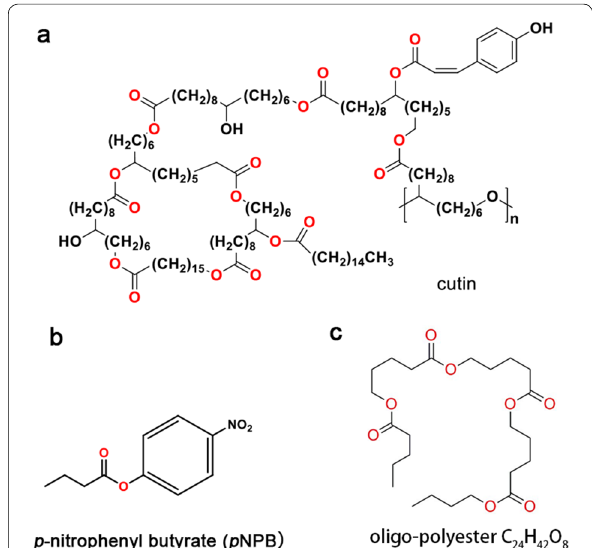
Fig. 1 Structures of compounds used in this study. a Cutin is the natural polyester substrate of cutinase. b p NPB is a small-model substrate of cutinase. The intramolecular ester oxygen atoms are colored in red. c The oligo-polyester C 24 H 42 O 8 was used for molecular docking